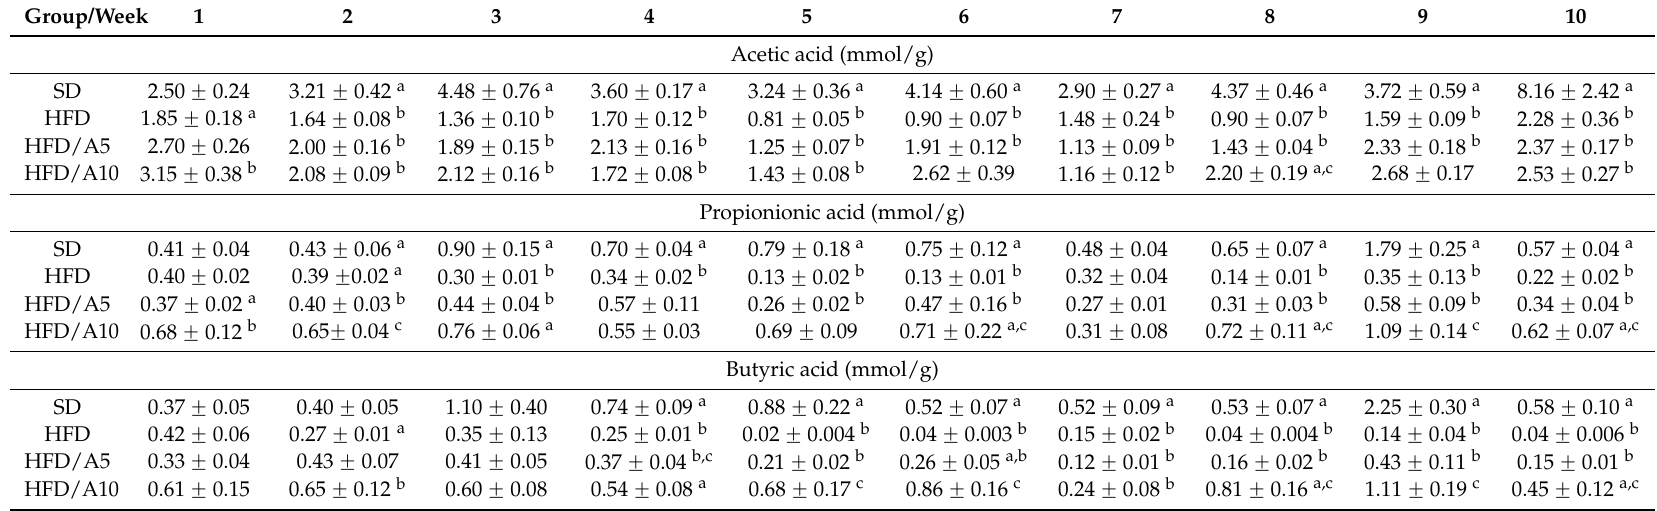
Table 3. Short chain fatty acids profiles at 10th week of